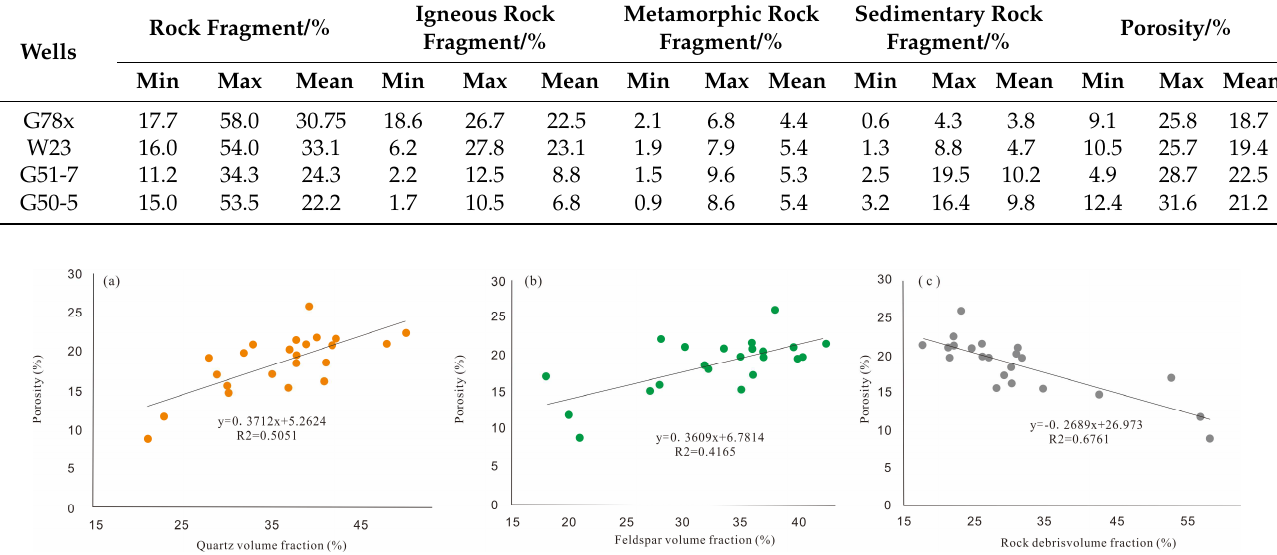
Figure 10. Relationship between particle size and physical properties of Z Ⅱ 3 in the Wang Guantun area. ( a ) porosity and median grain diameter ; ( b ) permeability and median grain diameter.